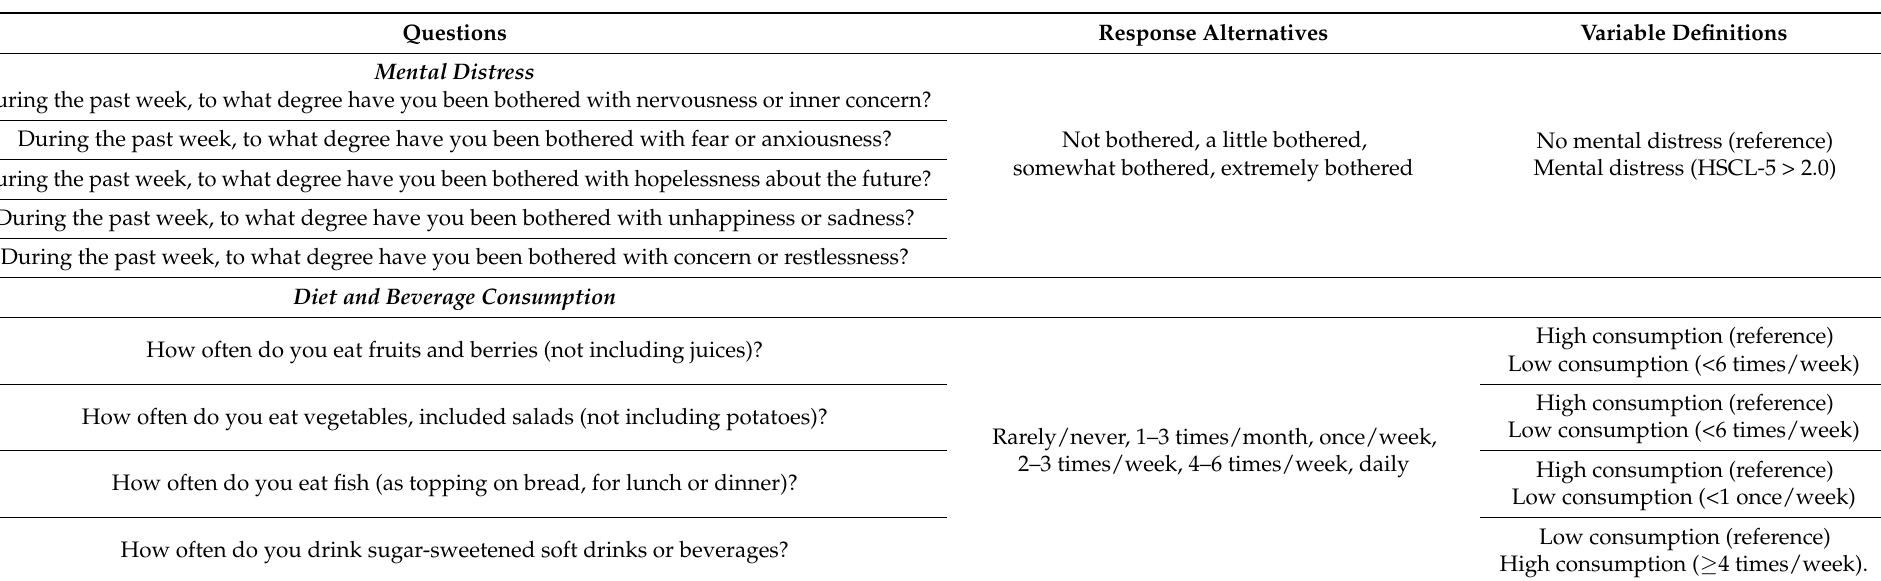
Table 1. Questions, response alternatives, and variable